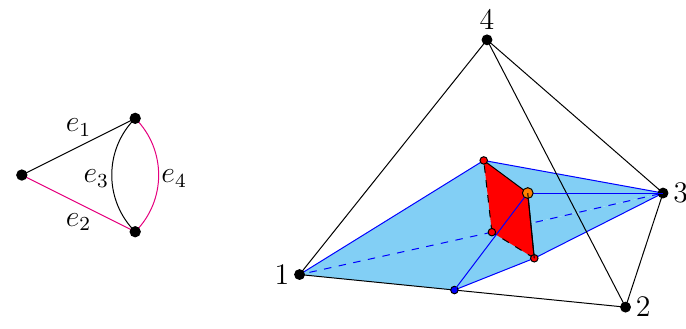
Figure 2 . Cube C T (red) and sector D T (blue) for T = { e 2 , e 4 } in the icecream-cone graph. The orange vertex marks the center of ∆ { e 1 , e 2 , e 4 } and { e 3 , e 4 }